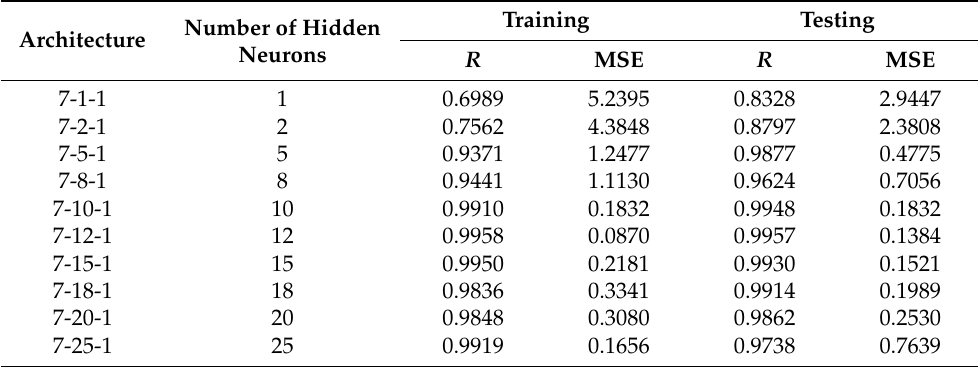
Table 10. Training and Testing R and MSE Results for ELM.